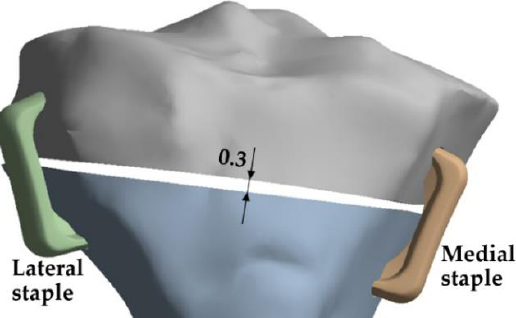
Figure 16. The average distance between the proximal and distal bone segment of the tibia (mm), deformation scale 10:1.